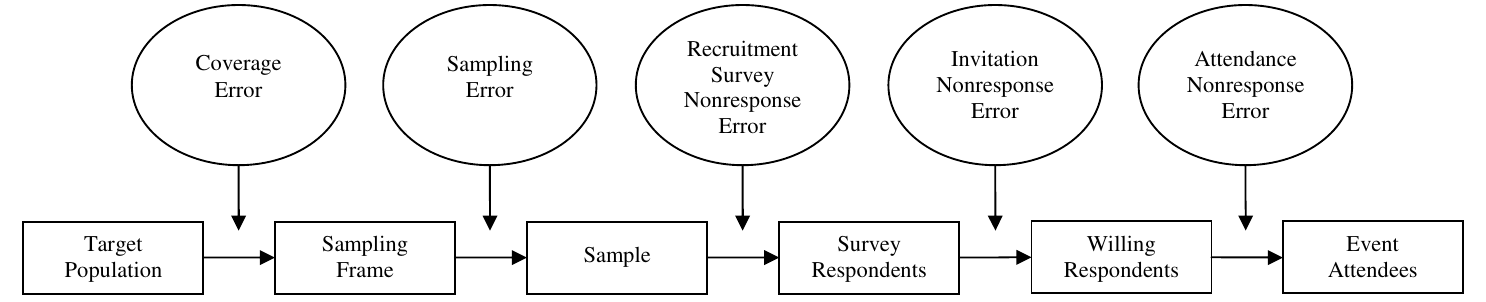
Figure 1. Deliberative event recruitment process error (adapted from Groves, et al.